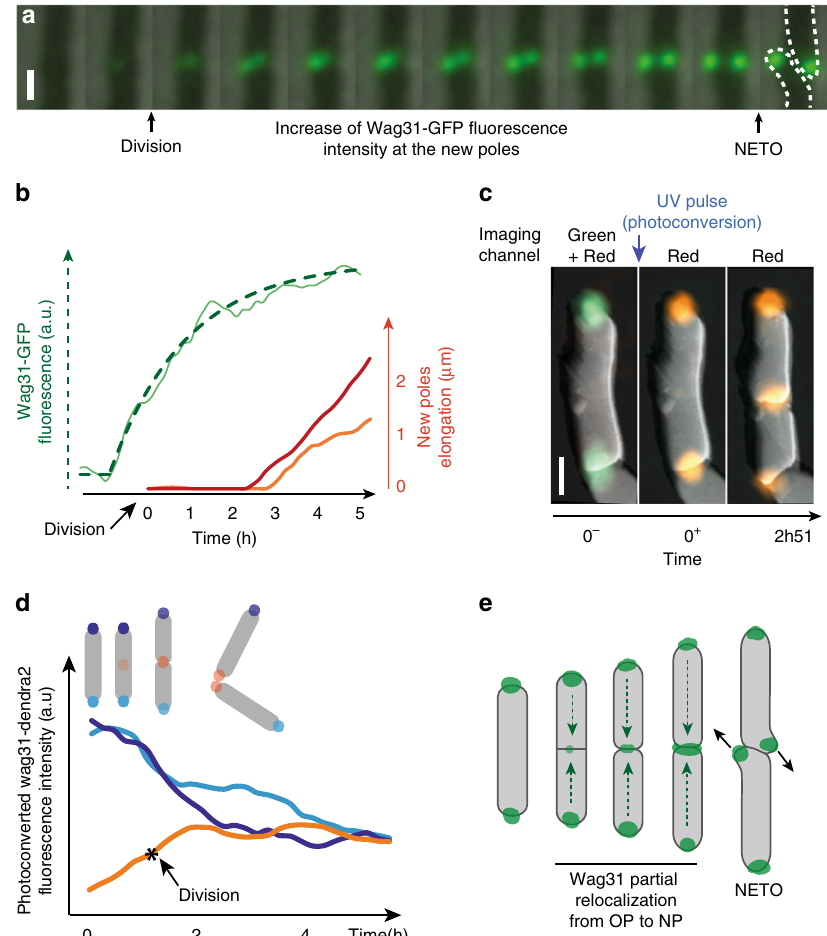
Fig. 5 Wag31 relocalizes from the old to the new pole during the pre-NETO phase. a Combined time-lapse phase-contrast and fl uorescence microscopy of M. smegmatis expressing Wag31-GFP. Zoom on the division site showing progressive formation of two elongating new poles. Time between consecutive images is 20 min. Scale bar, 1 μ m. b New-pole elongation curves of two sibling cells (red and orange) and the average of their Wag31-GFP intensities (green). Data are representative of 20 poles (Supplementary Fig. 7). The average intensity rather than individual intensity of the two new poles is plotted because their physical proximity precluded individual measurements. Wag31-GFP intensity over time was fi tted with an asymptotic exponential function (dotted green line) with a time constant of 1.9 h (con fi dence interval 0.26 at 95%), adjusted R 2 = 0.98. The con fi dence interval and R 2 value indicate the quality of the fi t to the fl uorescence curve. c Combined time-lapse fl uorescence and atomic force microscopy of M. smegmatis expressing Wag31-Dendra2 before (0 – ), just after (0 + ), and 2 h 51 min after (2h51) UV-induced photo-conversion. Scale bar, 1 μ m. d Evolution of photo-converted Wag31- Dendra2 signal at the new and old cell poles during cell division. Each sibling cell has a new pole (orange) and an old pole (light or dark blue) inherited from the mother cell. e Schematic representation of Wag31 relocalization from the old pole to the new pole during and after cell